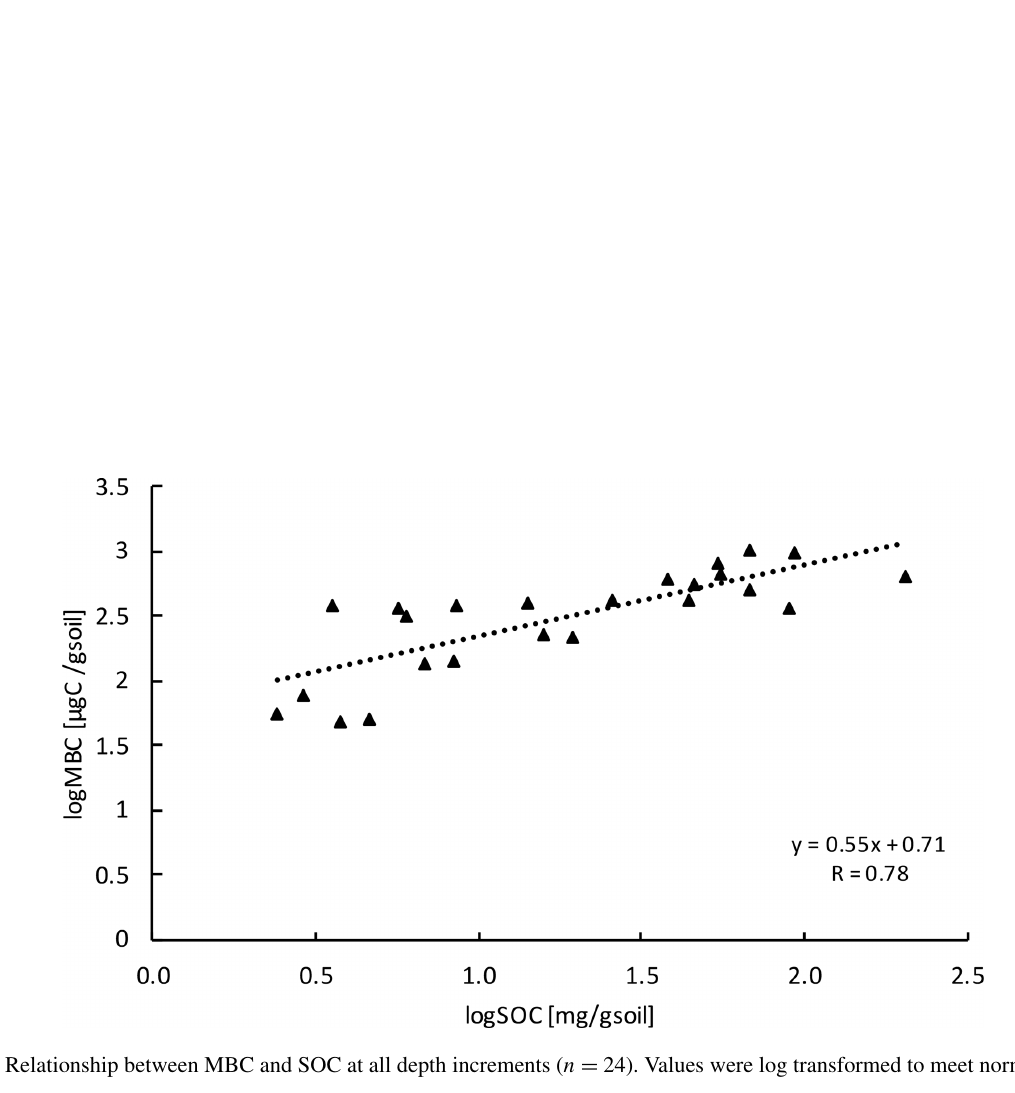
https://doi.org/10.5194/soil-7-477-2021 SOIL, 7, 477–494,